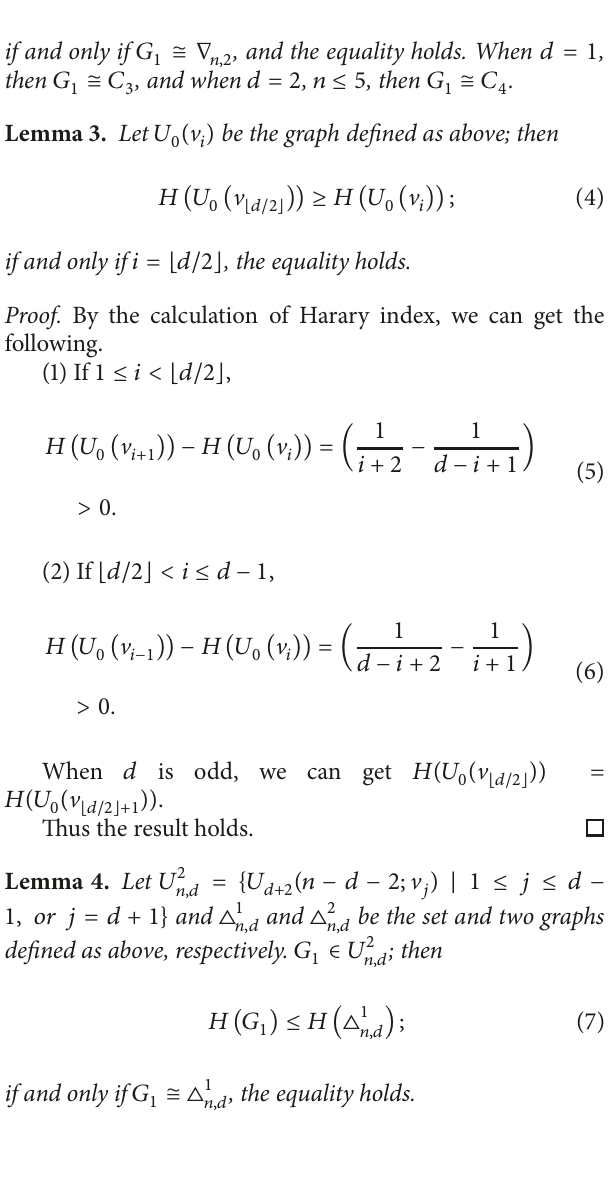
Figure 2: The graphs ∇ 𝑛,𝑑 and 𝑈 𝑑+2